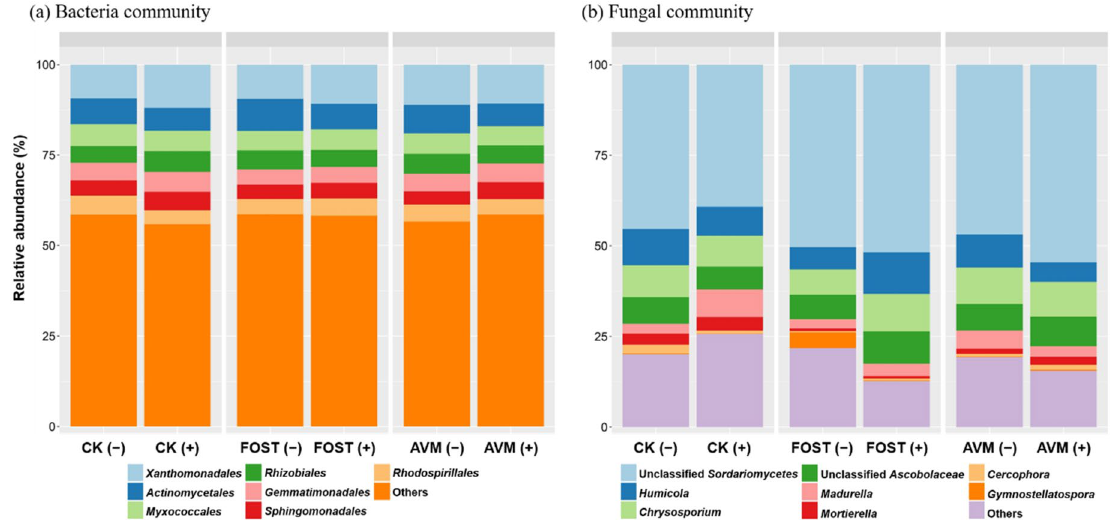
Figure 4. Taxonomic composition influenced by Burkholderia vietnamiensis B418 inoculation in different treatments at ( a ) order level for bacteria, and ( b ) genus level for fungi. CK: control; FOST: fosthiazate; AVM: avermectin. (+ /−) stands for with and without B418